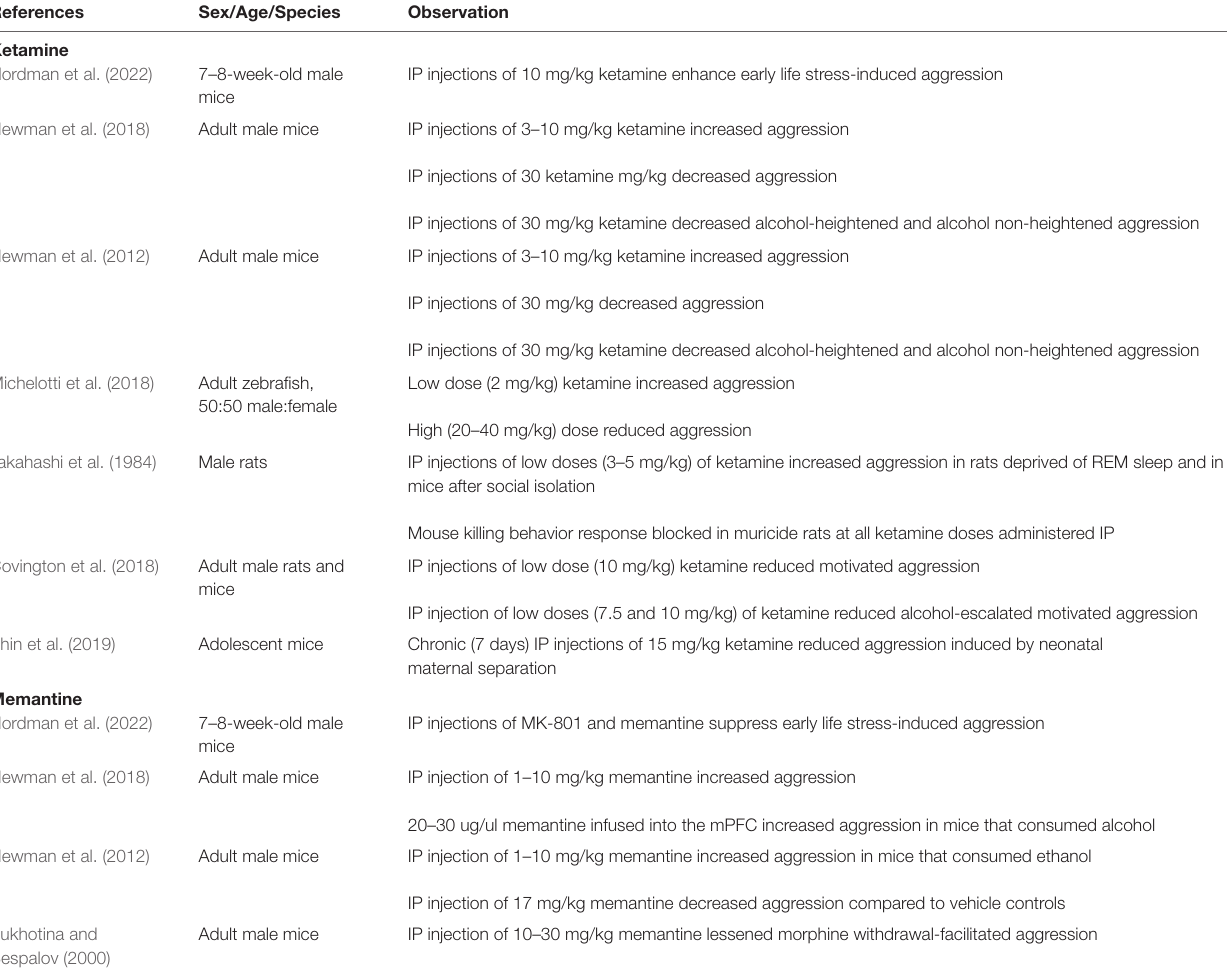
TABLE 2 | Animal studies on the effects of ketamine and